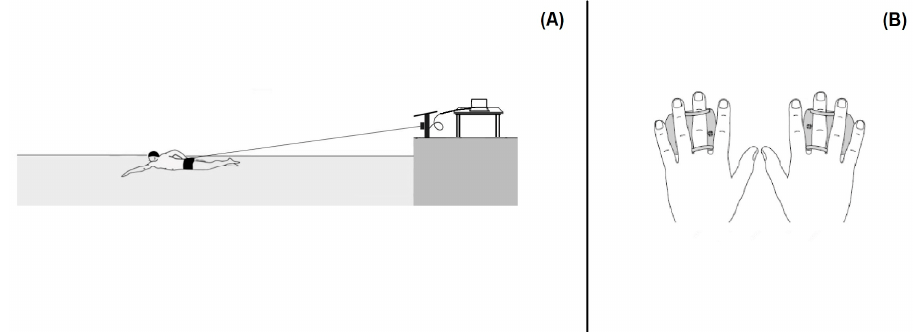
Figure 2. Panel ( A )—speedometer setup for the swimming velocity measurement. Panel ( B )—place- ment of the sensors for propulsive force measurement. of the sensors for propulsive force